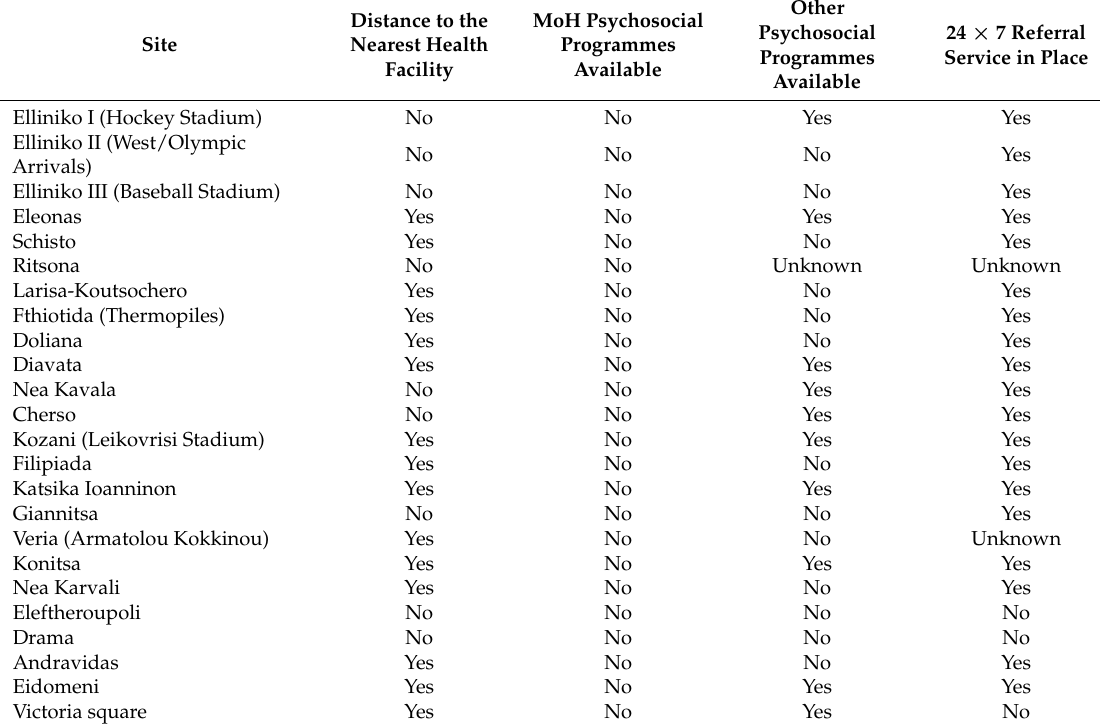
Table 8. UNHCR Health Services in Reception Centres